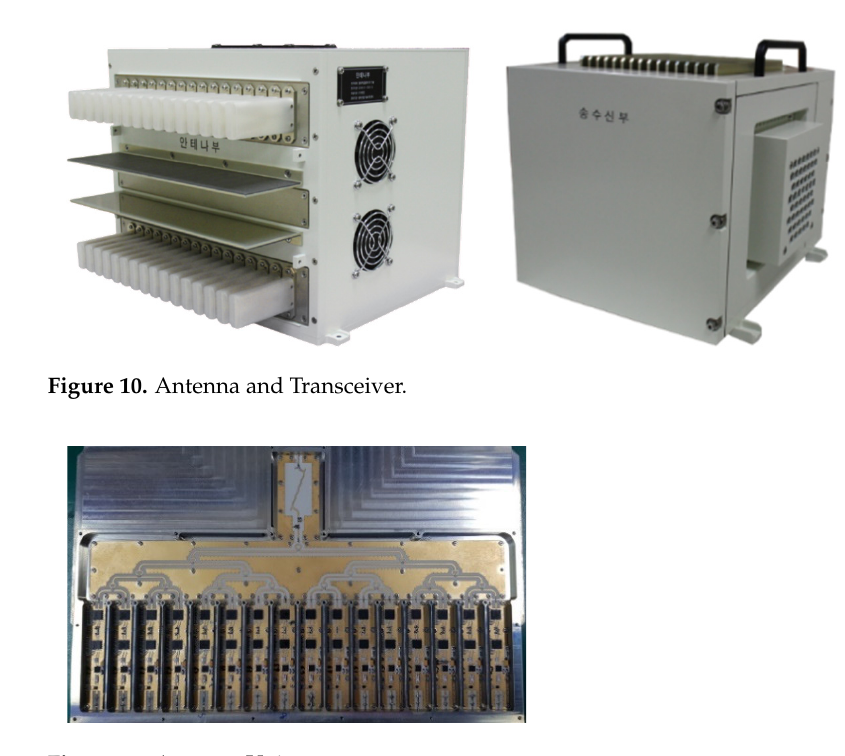
Figure 11. Antenna Unit.